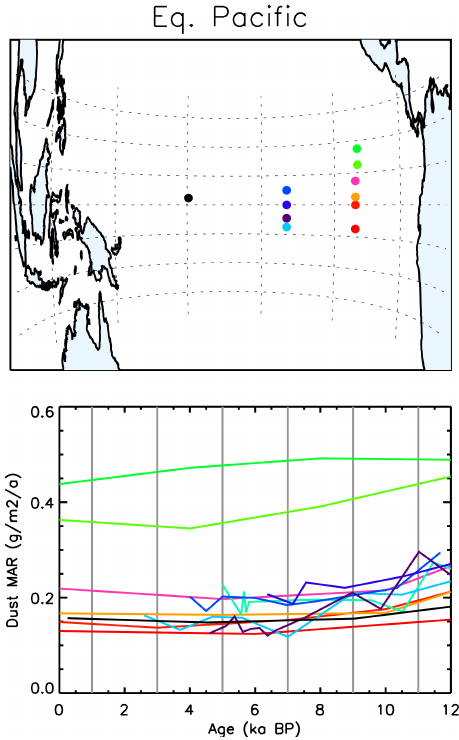
Figure 11. Same as Fig. 6 but for Greenland.